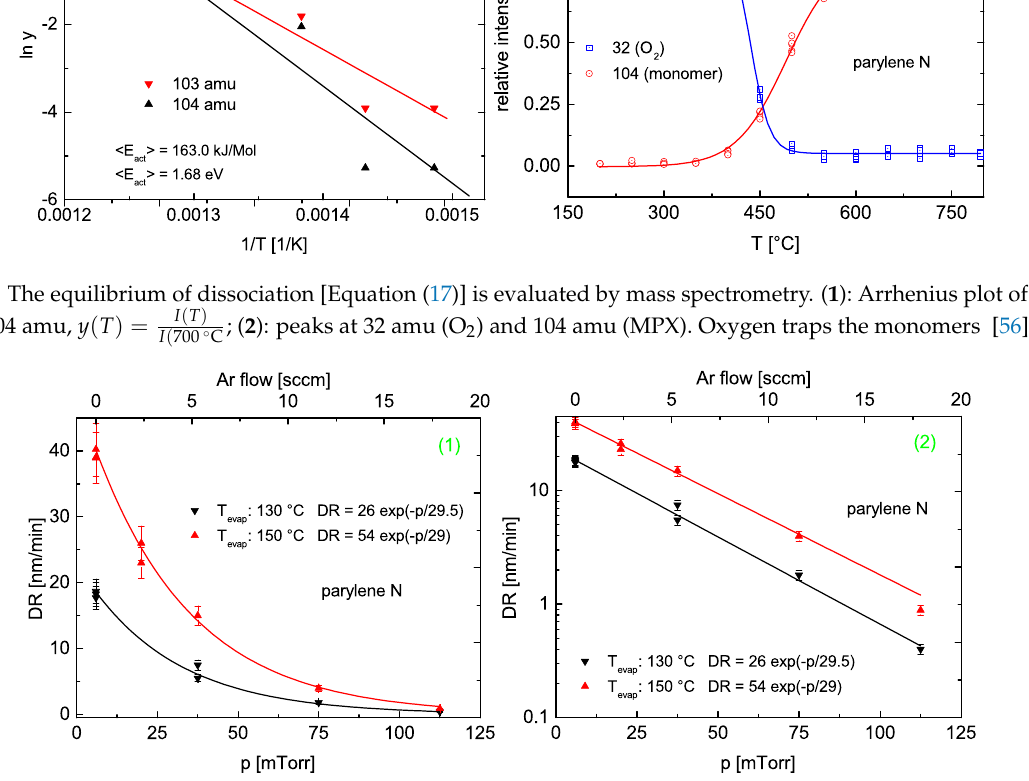
Figure 14. Deposition rate DR of MPX-N as function of reactor pressure p for two different temperatures, ( 1 ): linear scale, ( 2 ): logarthmic scale. The deposition rate increases exponentially with rising absolute temperature, and decreases exponentially with rising argon flow